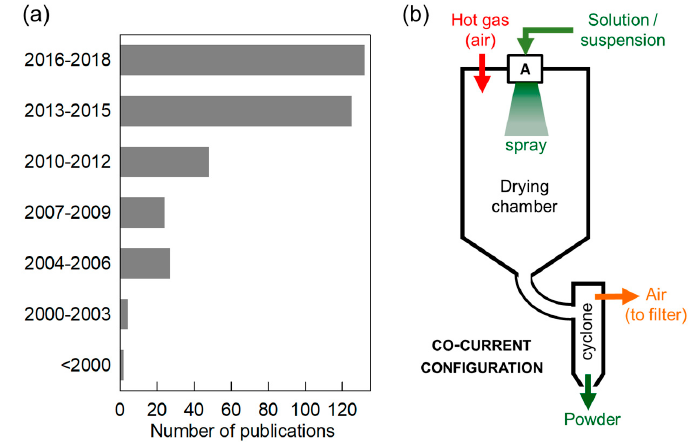
Figure 1. ( a ) Number of publications related to spray-drying of electrode materials for Li-ion, Na-ion and related batteries; ( b ) Schematic of a spray-dryer, showing the case of a co-current configuration and bi-fluid nozzle atomization.